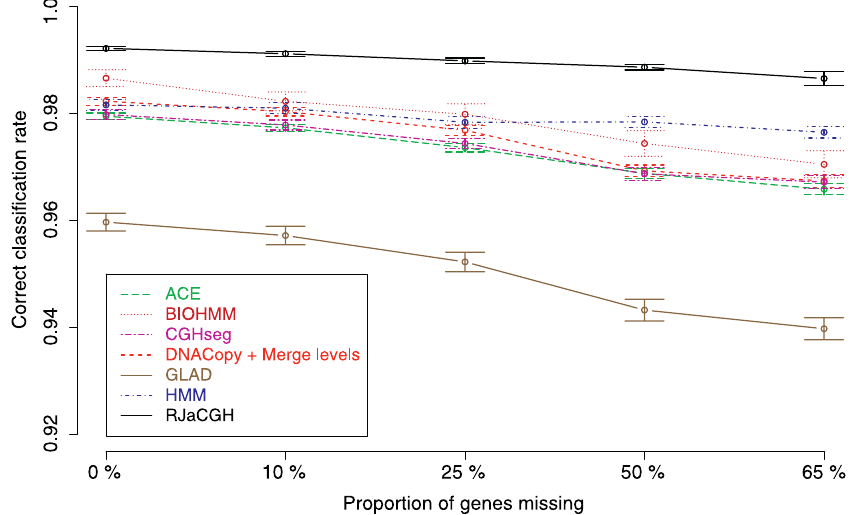
Figure 1. Effects of Variability in Interprobe Distance (Percentage of Probes Missing) on Correct Classification Shown are the mean and 95% confidence interval around the mean of the correct classification error rate. Each mean and confidence interval is computed from 500 datasets [31]; see text and Protocol S1 for generation of interprobe distance variability. Alternative methods compared are ACE, developed by [27]; BioHMM, a nonhomogeneous HMM by [18]; DNAcopy with mergeLevels, with the original method developed by [24] (and use of mergeLevels following [31]); HMM, a homogeneous HMM developed by [19]; CGHseg, a random Gaussian process with abrupt changes in the mean by [28]; and GLAD, which uses a nonparametric likelihood method with adaptive weights for breakpoint detection, by [23].